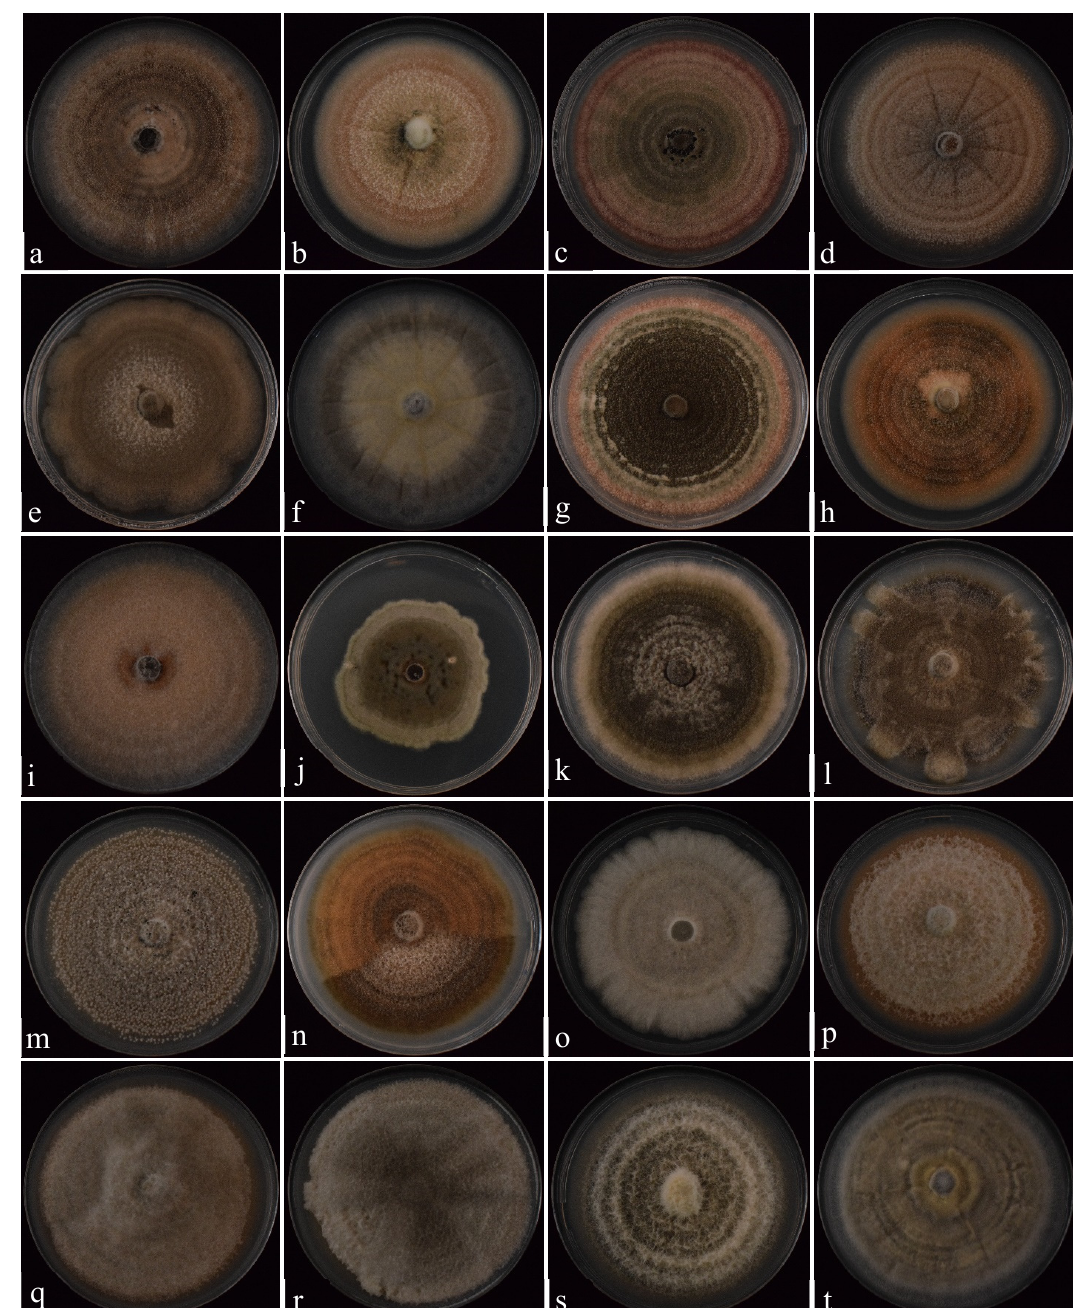
Figure 2. Variability in the colonies of representative Colletotrichum isolates belonging to the following species complexes: ( a – l ) Colletotrichum acutatum ; ( m , n ) C. boninense and ( o – t ) C. gloeosporioides . Colonies were grown on PDA for 14 days at 25 ± 2 °C under a 12-h daily photoperiod of cool fluorescent light (350 μ mol m –2 s –1 ). ( a – d ) C. acutatum (( a ) Col-166, ( b ) Col- 175, ( c ) Col-208, ( d ) Col-536); ( e – h ) C. fioriniae (( e ) Col-172, ( f ) Col-693, ( g ) Col-695, ( h ) Col-696); ( i , j ) C. godetiae (( i ) Col-88, ( j ) Col-522); ( k ) C. nymphaeae Col-42); ( l ) C. simmondsii Col-169 ( m ) C. boninense Col-178; ( n ) C. karstii Col-79; ( o , p ) C. alienum (( o ) Col-211, ( p ) Col-214); ( q ) C. gloeosporioides Col-69; ( r , s ) C. siamense (( r ) Col-44, ( s ) Col-160); ( t ) C . theobromicola Col-200.